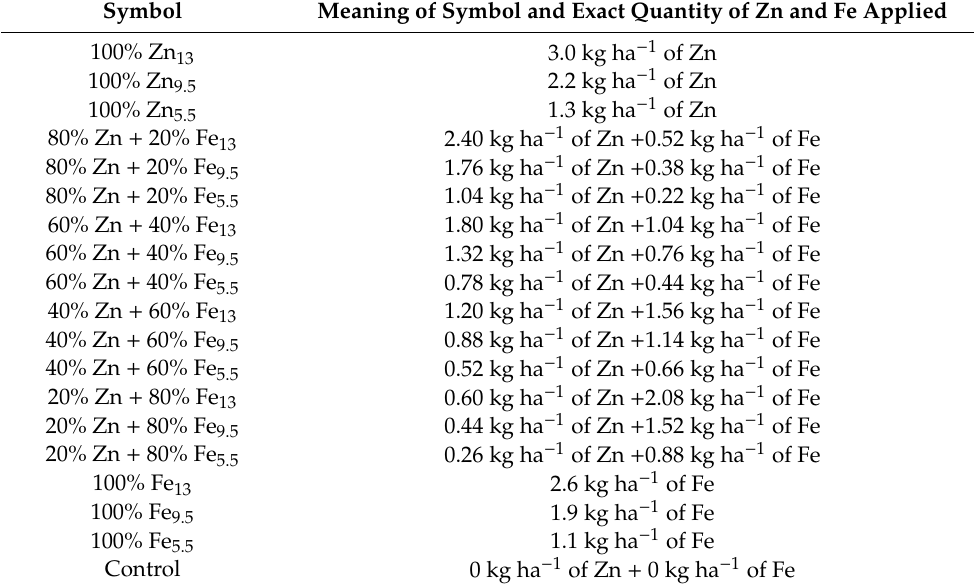
Table 1. Meanings of symbol used for